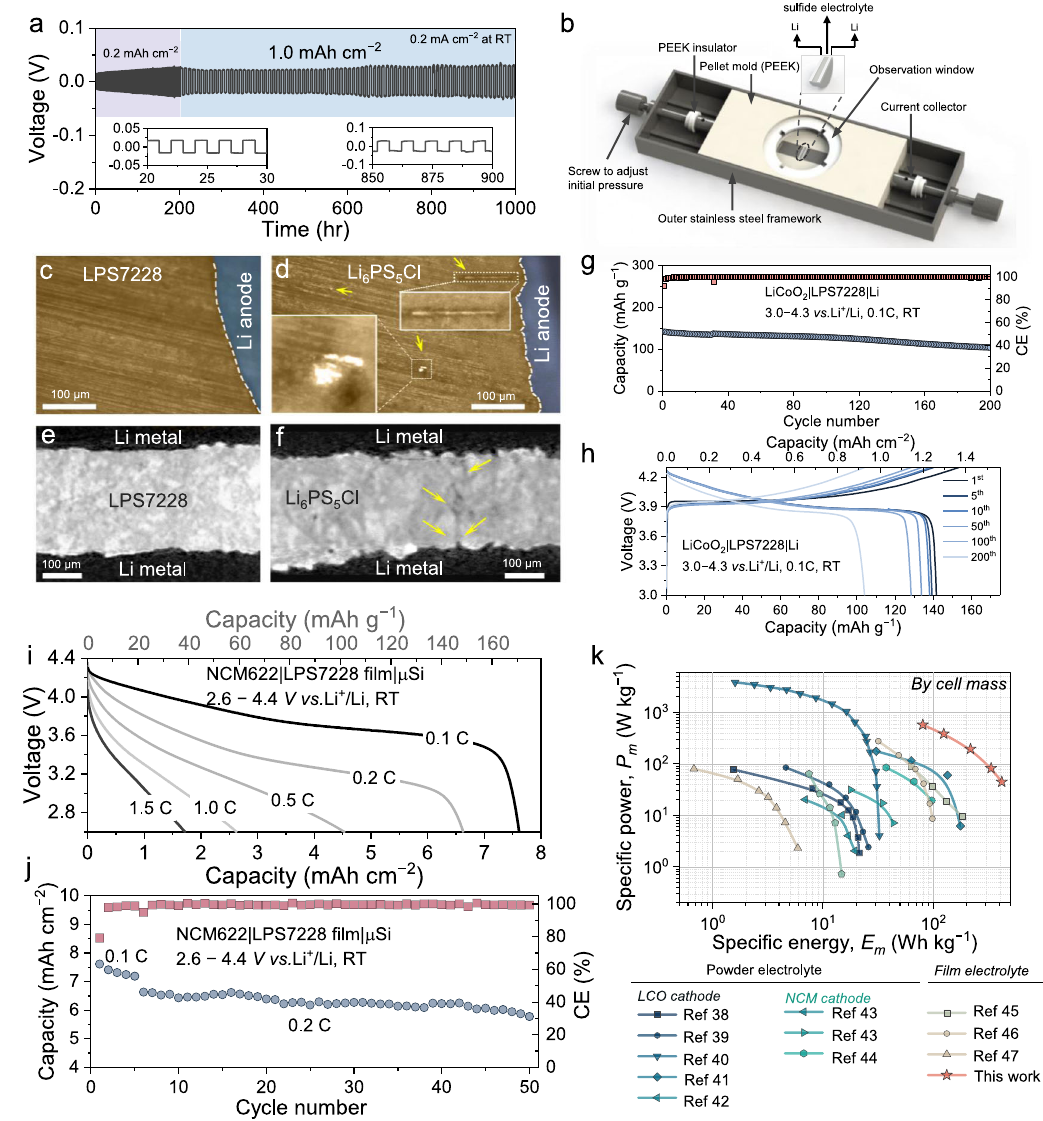
Fig. 4 | Demonstration of LPS7228 in ASSBs. a Galvanostatic cycling of the Li| LPS7228|Li cell at a current density of 0.2mAcm − 2 and areal speci fi c capacities of 0.2 or 1.0mAh cm − 2 at room temperature. b Schematic view of the home-made device for operando optical microscopy observation. Top-down optical observa- tion of ( c ) Li|LPS7228|Li and ( d ) Li|Li 6 PS 5 Cl|Li symmetric cells after 10h cycling. Sliced images of the reconstructed tomographic volumes of ( e ) Li|LPS7228|Li and